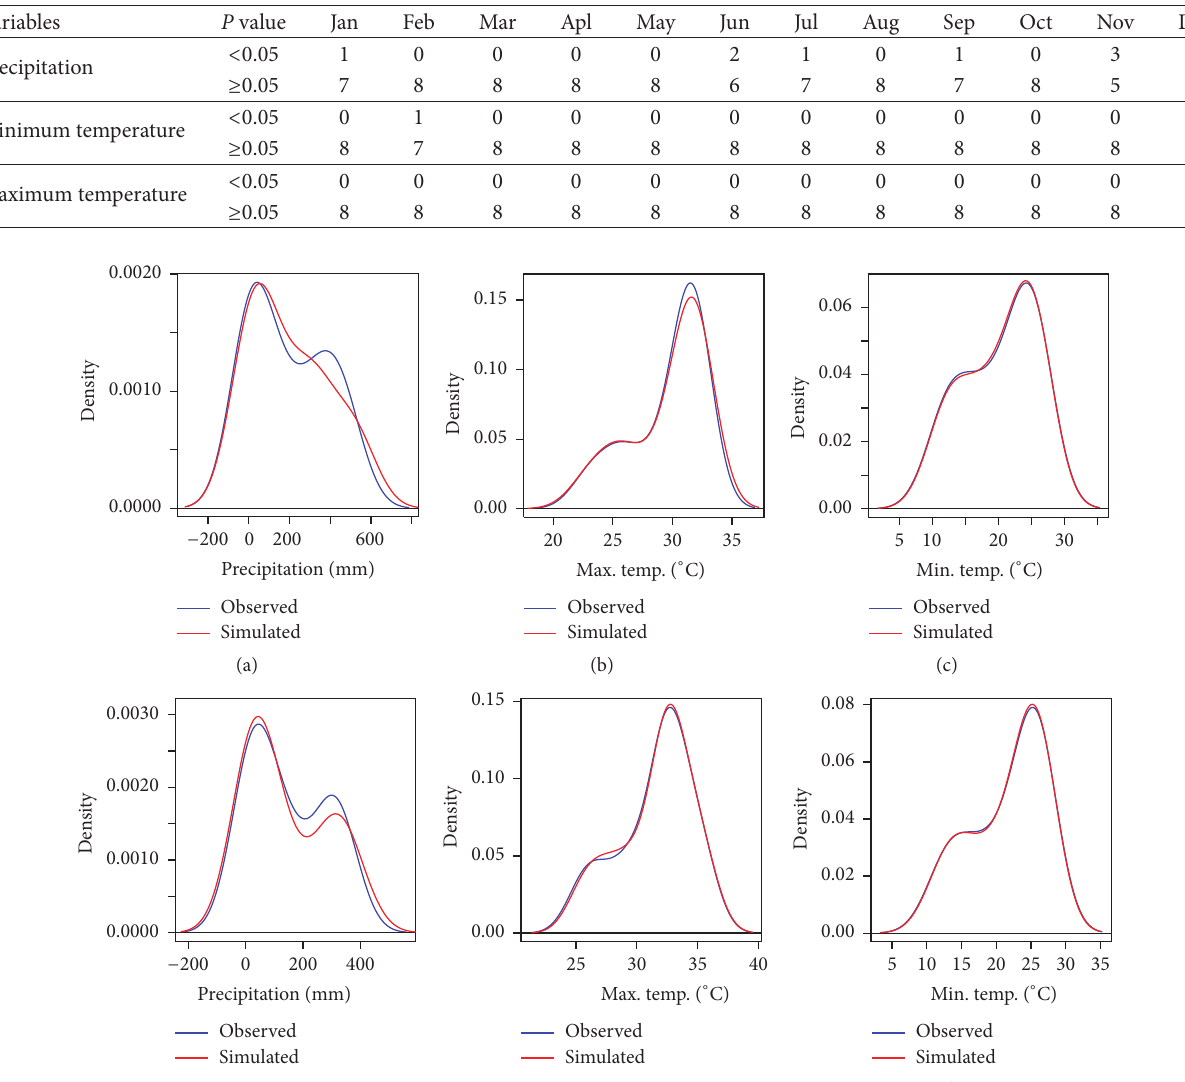
Table 3: The results of Q -test for precipitation and minimum and maximum temperature at 8 meteorological stations in the study area (unit: number of station).